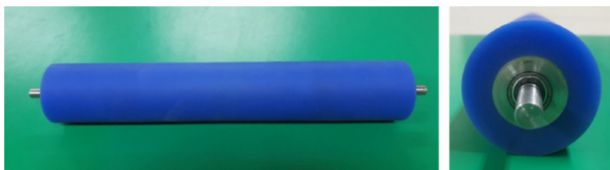
Figure 13. Optimized barrel roller fabricated with final design parameters.